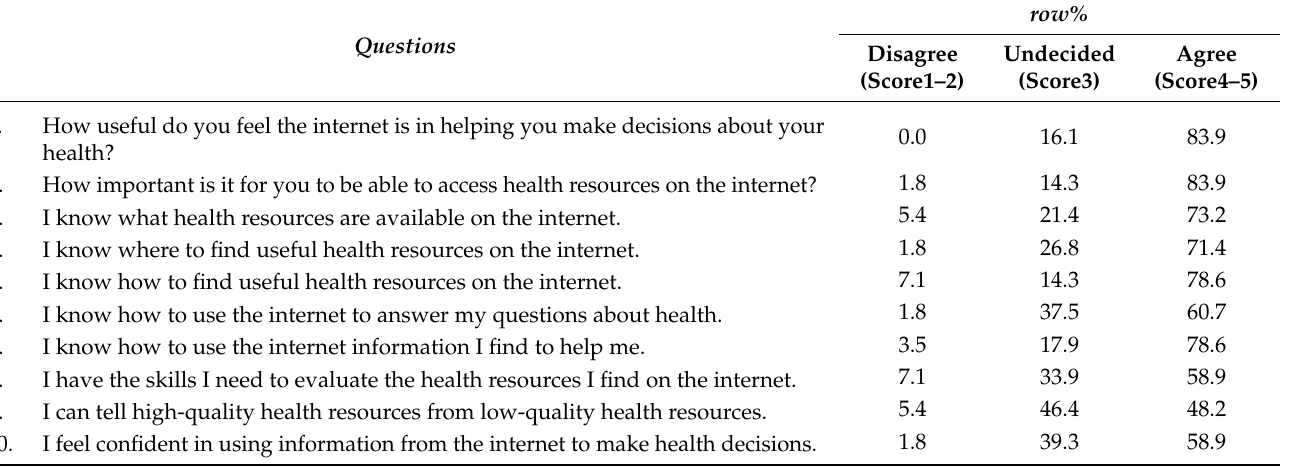
Table 2. Electronic Health Literacy Scale (eHEALS) scores among internet users ( n = 56).